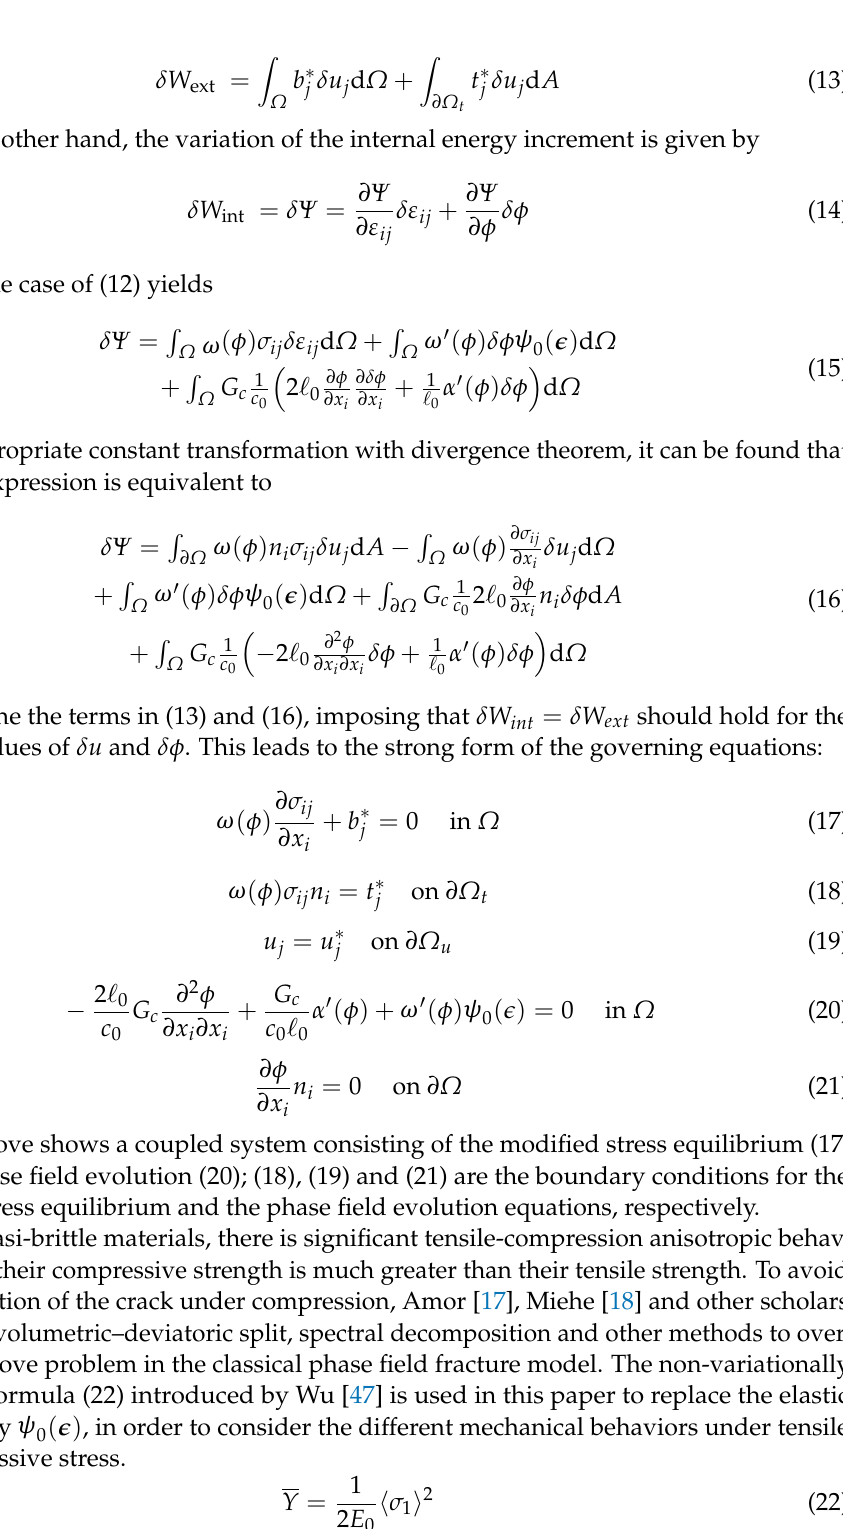
∂𝛺 is denoted as 𝒏 .